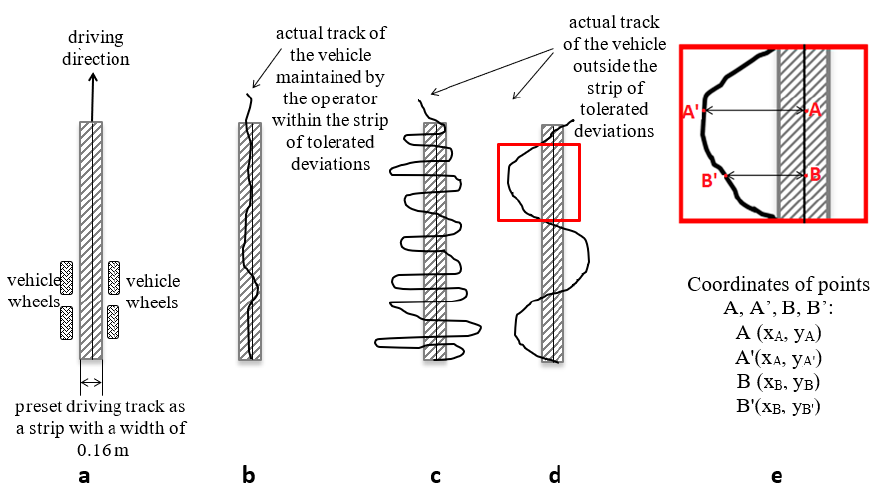
Figure 1. Horizontal plan showing the preset driving track and the actual driving track; ( a )—tractor driving direction on a 20 m track, tolerance deviation strip 0.16 m, ( b )—correct drive (driving track maintained in the tolerated deviations track), ( c , d )—incorrect drives; despite the differences, classified the same, i.e., as an incorrect drive, ( e )—spatial parameters of deviations of the actual drive track from the preset track.